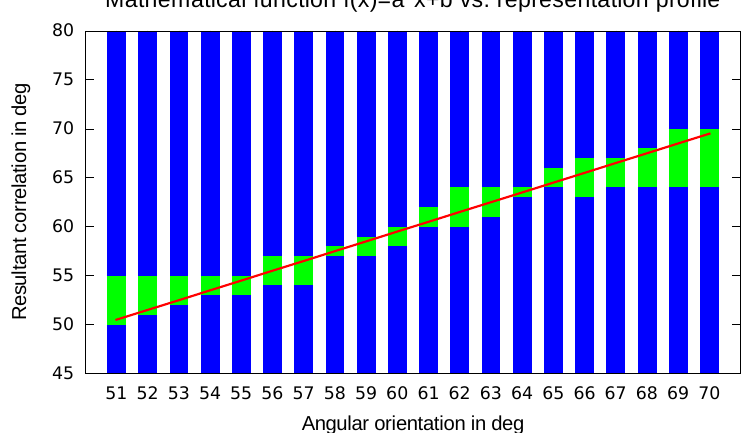
Figure 4. The figure shows the correlation profile of an active state of a system on the y -axis in the context of orientation of a line presented to the system, as denoted on the x -axis. While this may be a trivial example where the domain and codomain are same, it serves to illustrate the difference from function-based representation. The color bands on the vertical bars represent the extents of values in a domain that correlate with the state of a physical entity in the context of a value in another, as represented on the x -axis. The green band indicates the range of positive correlations, while the blue band designates the negative correlations. The line in red represents the value of the function at respective x -values. The data is taken from a run of the simulation, as presented in Section 7. Here, the x -value represents the orientation of an object in discrete steps of 1 degree of arc in the field of observation, while the different ranges on the bar shows the correlation bands of the state.